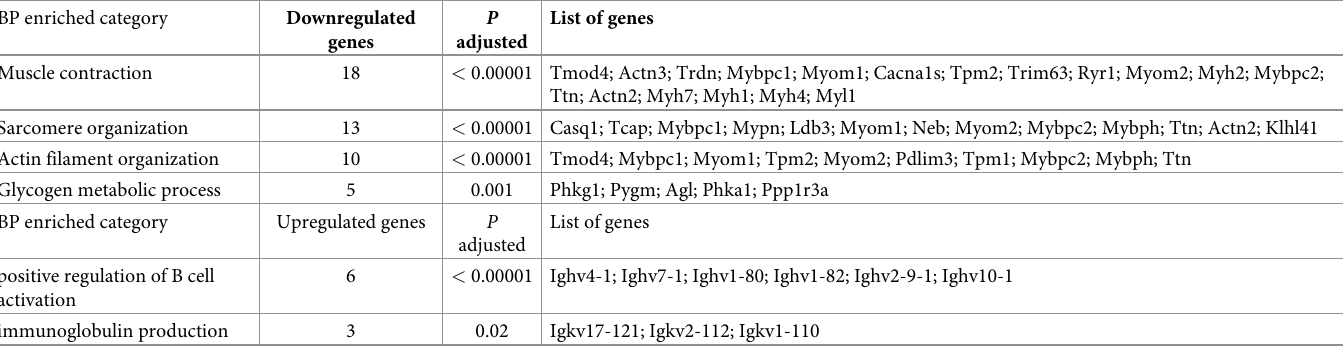
Table 1. Biological process (BP) enriched categories obtained by gene ontology analysis.